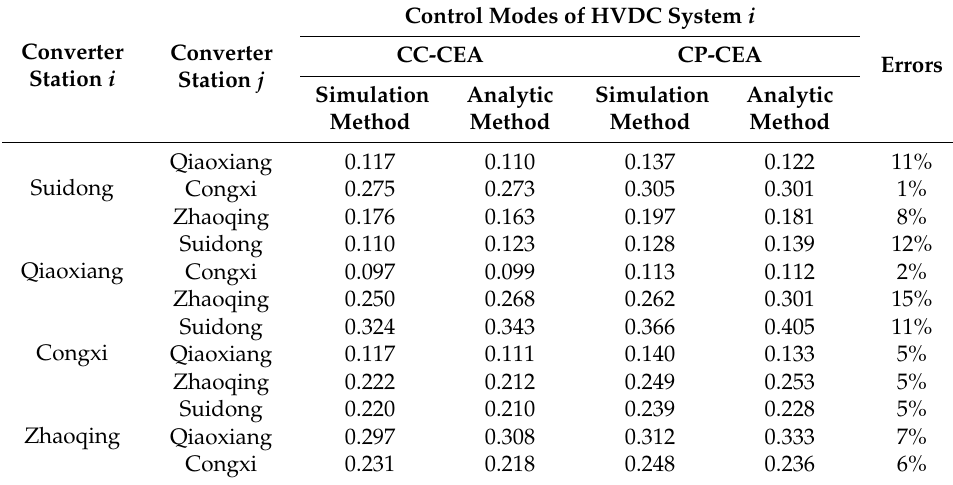
Table 4. Calculation results of actual